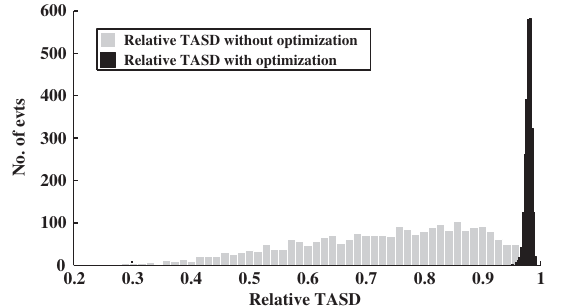
FIG. 16. Relative TASD results for ξ 2500 ð 3 . 8 μ rad ; 20 μ rad ; 20 μ m Þ simulated and optimized. The histogram in grey shows the relative TASD before the alignment procedure (SIMPLEX algorithm) and the black histogram shows the relative TASD reached after the optimization.